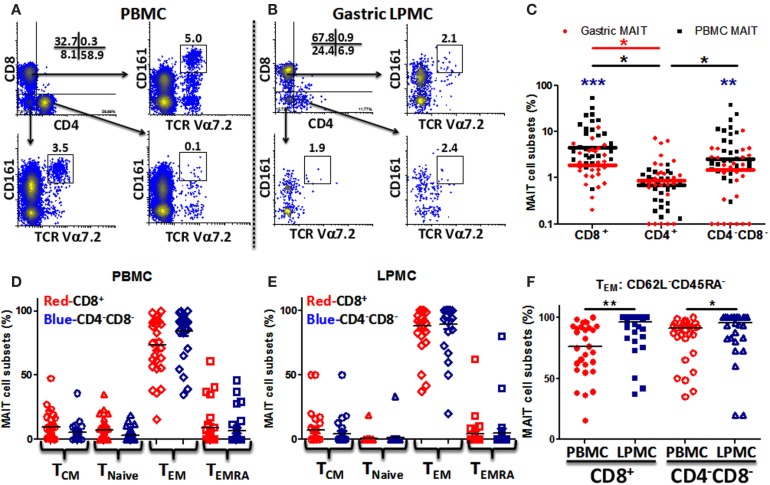
MAIT cells are present in the human gastric mucosa and exhibit T effector memory phenotype. (A) Identification of MAIT cell subsets [CD8+, CD4+, and CD4−CD8− (DN)] in PBMC and (B) in gastric LPMC in a representative individual as CD161hi TCR Vα7.2 (box). (C) Comparison of gastric (red dots; n = 27) and PBMC (black squares; n = 29) MAIT cell subsets. Significant differences between MAIT cell subsets in (i) PBMC [black asterisks (*)] and (ii) gastric LPMC [red asterisk (*)]. Blue asterisks (*) denote significant differences in MAIT cell subsets between PBMC and LPMC. Horizontal lines represent medians (red bars: gastric MAIT; black bars: PBMC MAIT). (D) Expression of CD45RA and CD62L to evaluate memory [TCM (CD62L+CD45RA−), TEM (CD62L−CD45RA−), and TEMRA (CD62L−CD45RA+)] and Tnaive (CD62L+CD45RA+) subpopulations in MAIT subsets from PBMC (n = 29) and (E) LPMC (n = 27). (F) Comparison of TEM MAIT cell subsets between PBMC and LPMC. *P < 0.05; **P < 0.005; ***P < 0.0005.